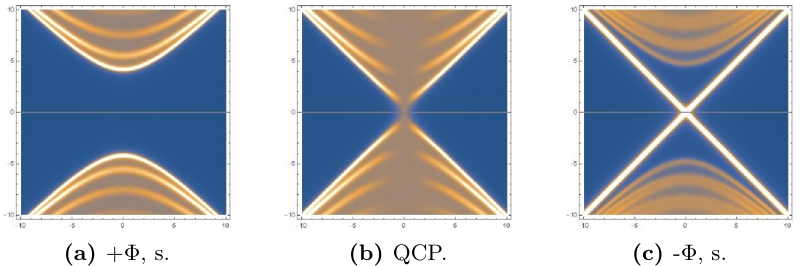
Figure 1. Spectral Function(SF) for the one flavor. (a) Gap with positive coupling with the order. (b) QCP: the spectrum of zero coupling. (c) zero mode with negative coupling. There is a metal insulator transition at the QCP. Fig. 1A with the electron wave vector perpendicular to the G K direc-